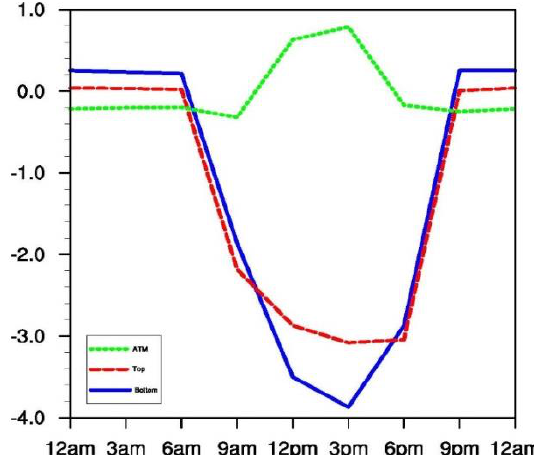
Figure 12. Diurnal profile of sulfate aerosol direct radiative forcing (W m − 2 ) over East Asia in 2010.